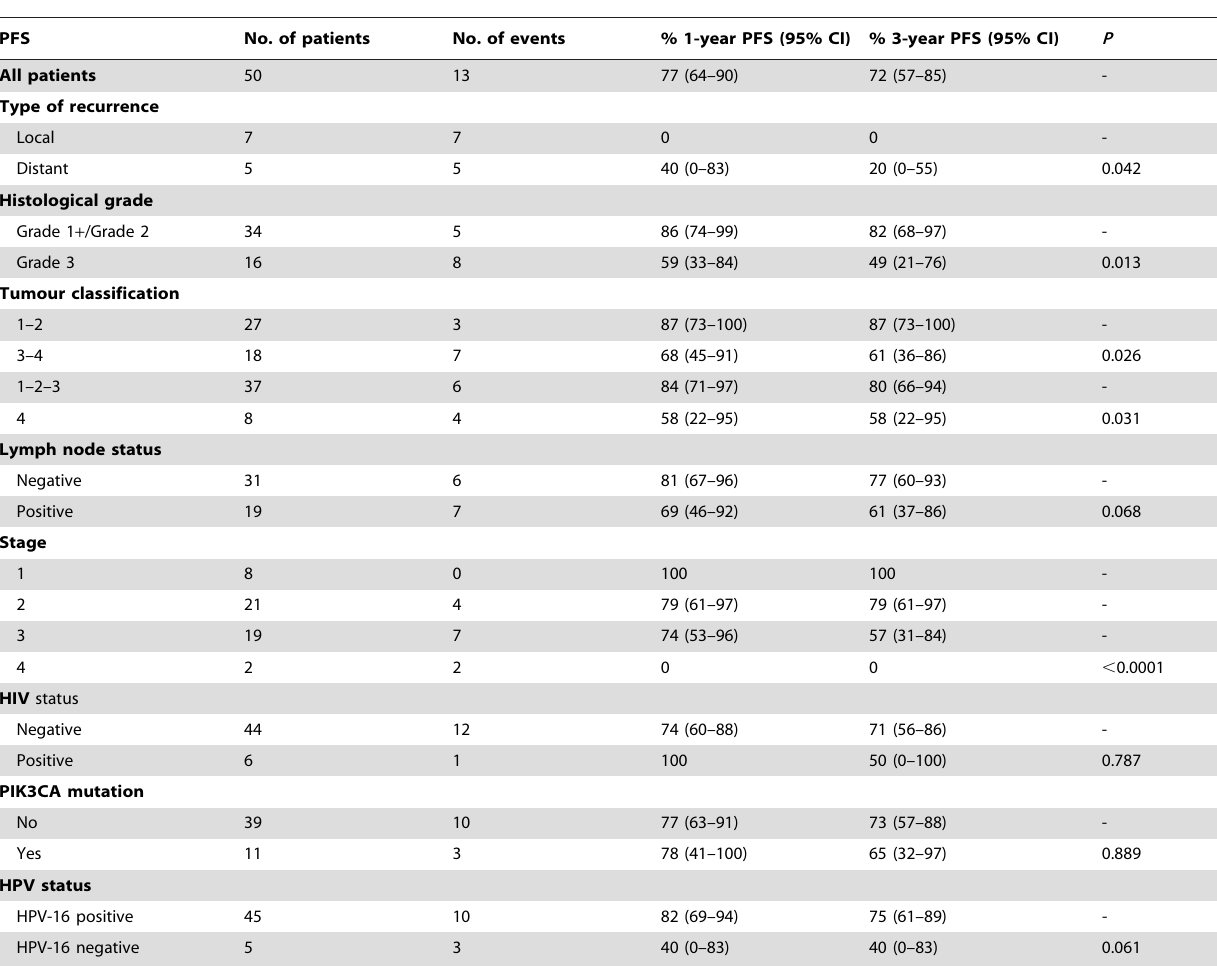
Table 3. Progression-free survival in relation to clinical-pathological characteristics of